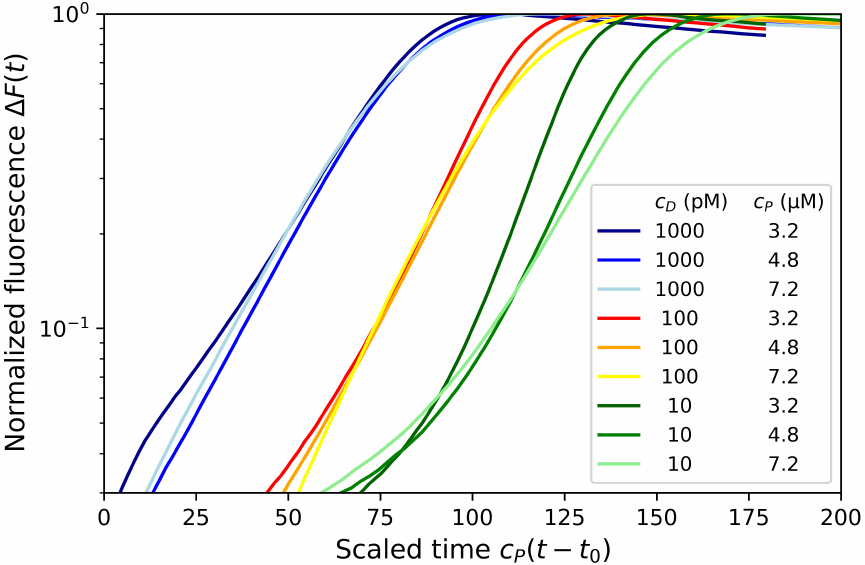
Figure 3. Normalized fluorescence ∆ F in logarithmic scale on the y-axis as function of scaled time c P ( t − t 0 ) (in µ M.min) for three concentration of primers ( c P = 3.2,4.8,7.2 µ M) and three MD dumbbell concentrations c D = 1000,100,10